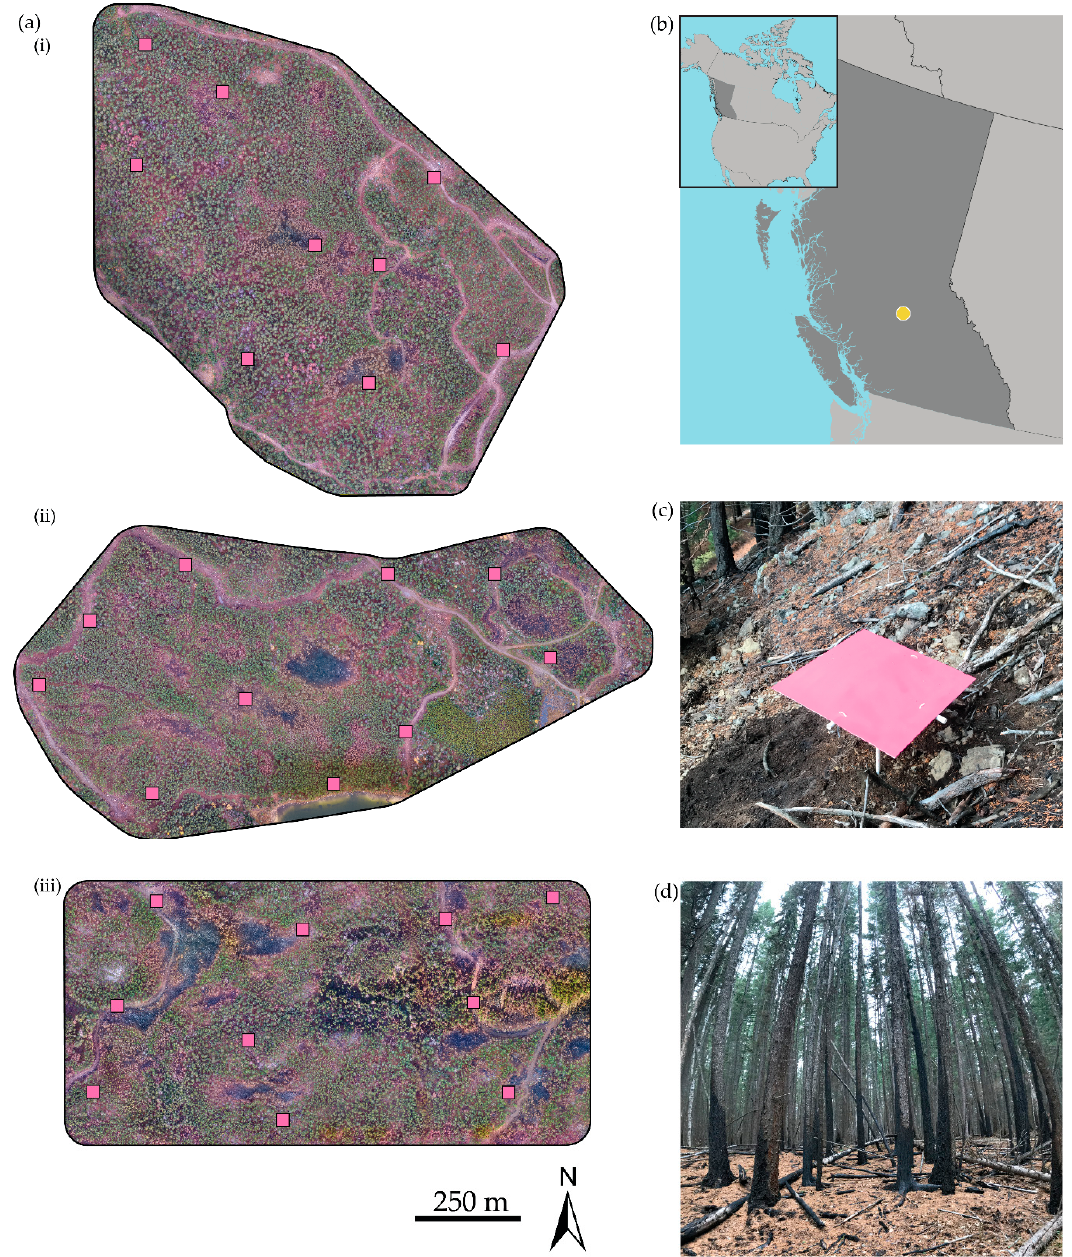
Figure 2. UAV acquired orthomosaics ( a ) of study areas A, B and C ( i , ii , and iii ) respectively with overlaid GCP locations, study area northeast of Williams Lake, BC ( b ), an example photo of GCP (0.7 m × 0.7 m) situated on steep slope in study area A ( c ), and subcanopy image taken at the northwest corner of study area A ( d ). The coordinate system used throughout this study is X, Y: NAD83, UTM Zone 10 N; and Z: NADV 88.